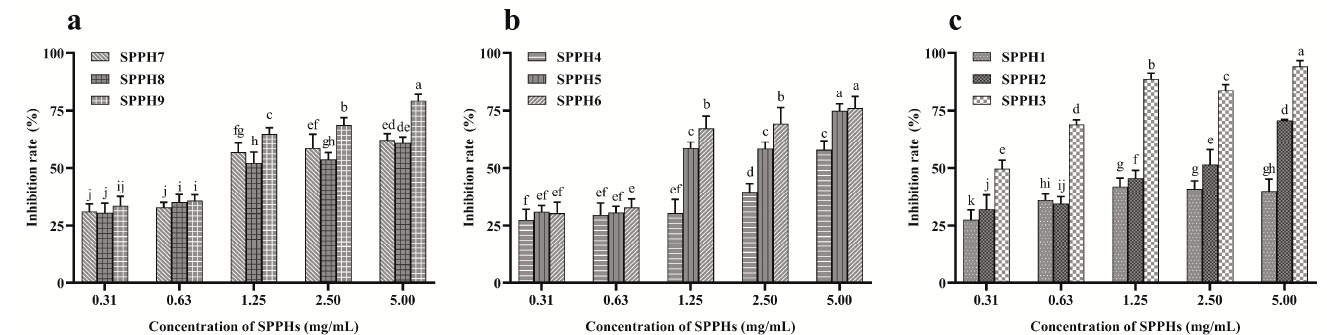
Figure 2. The proliferation inhibition of SPPHs on MGC-803 cells. ( a ) IR of SPPH7, SPPH8 and SPPH9; ( b ) IR of SPPH4, SPPH5 and SPPH6; ( c ) IR of SPPH1, SPPH2 and SPPH3. Each bar represents the mean ± standard of at least three separate experiments. All the data were analyzed by Duncan’s multiple comparisons; bars with no letter in common are significantly different at the level of p < 0.05.